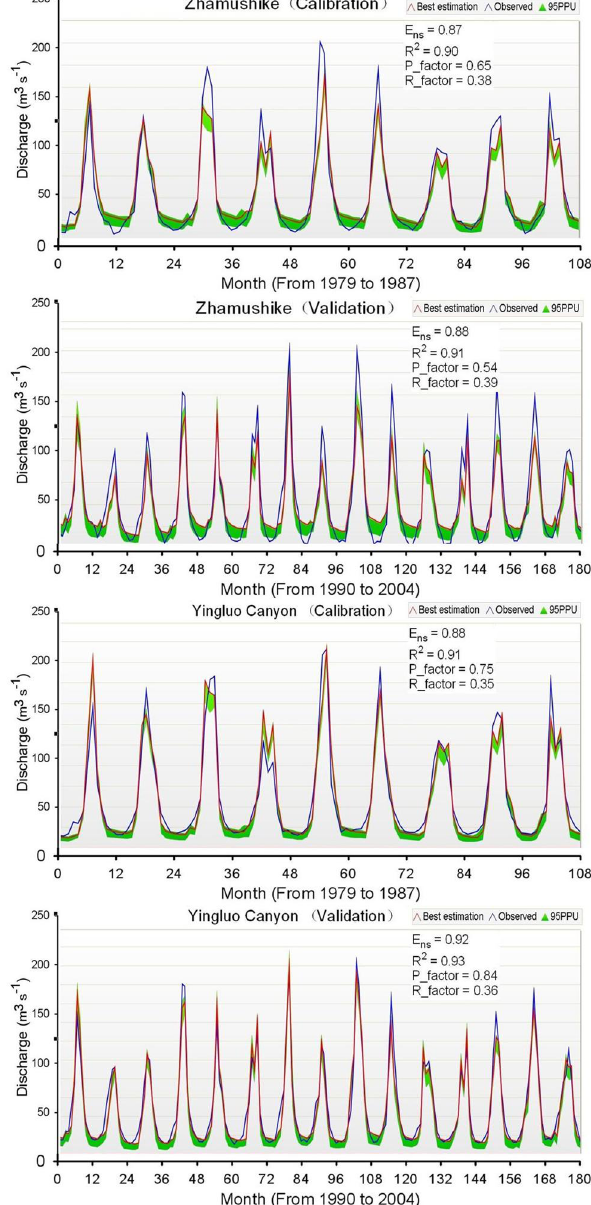
Fig. 2. Comparisons between the observed and simulated (ex- pressed as 95% prediction uncertainty band) discharge for the Zhamushike and Yingluo canyon hydrological stations in Heihe river